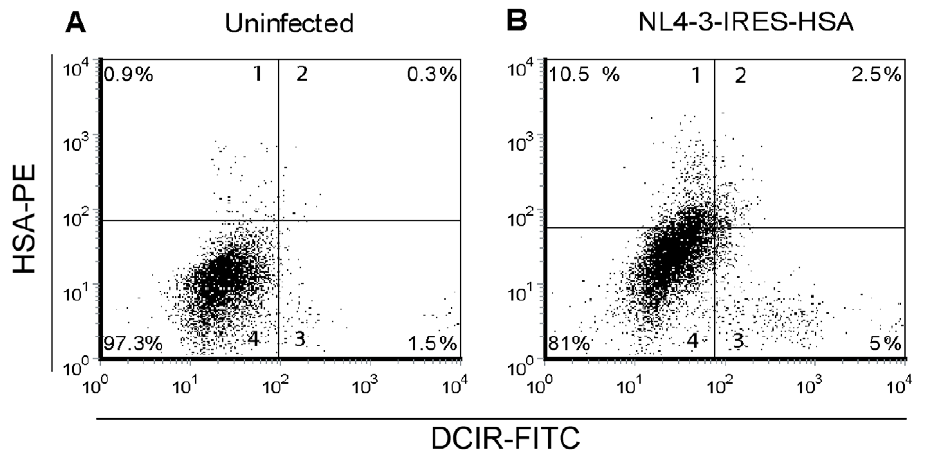
Figure 2. DCIR is expressed in both virus-infected and bystander CD4 + T cells. Cells (1 6 10 6 ) were either left (A) uninfected or (B) infected with NL4-3-IRES-HSA reporter virus (100 ng of p24). Three days later, a double-stain flow cytometric method was performed to assess the percentages of DCIR-expressing and HSA-positive cells. Data shown correspond to a single experiment representative of 3 independent experiments.